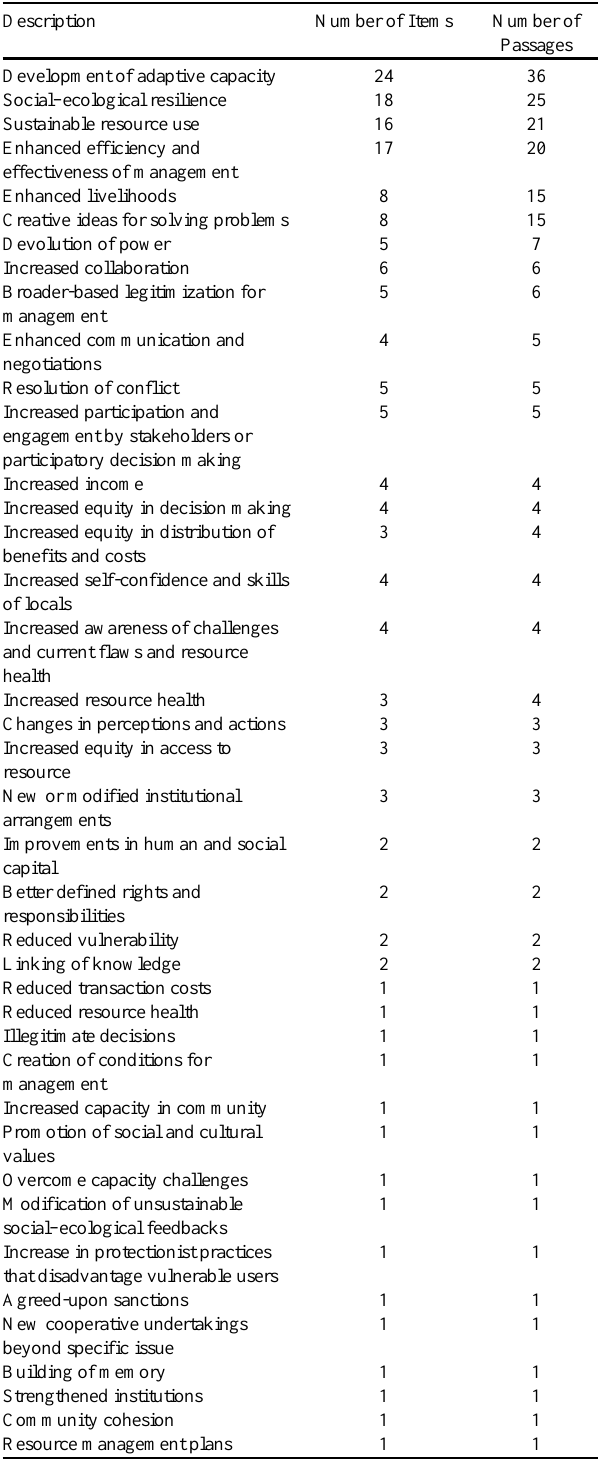
Table 4. Potential outcomes of adaptive